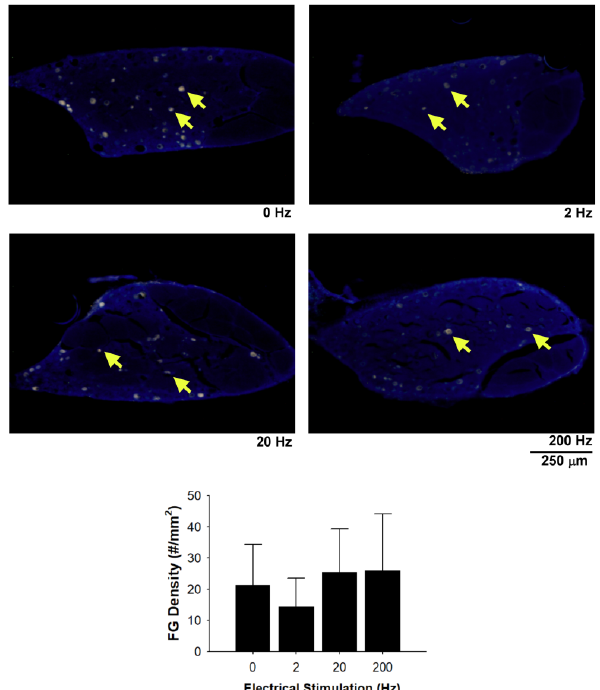
Figure 5. Representative images of the retrograde axonal tracing with fluorogold (arrows) in taxol-treated rats. No significant difference was seen in the number of fluorogold-labelled cell in dorsal root ganglions (DRGs) among the four groups with different frequencies of electrical stimulation. Scale bar = 250 µ m.